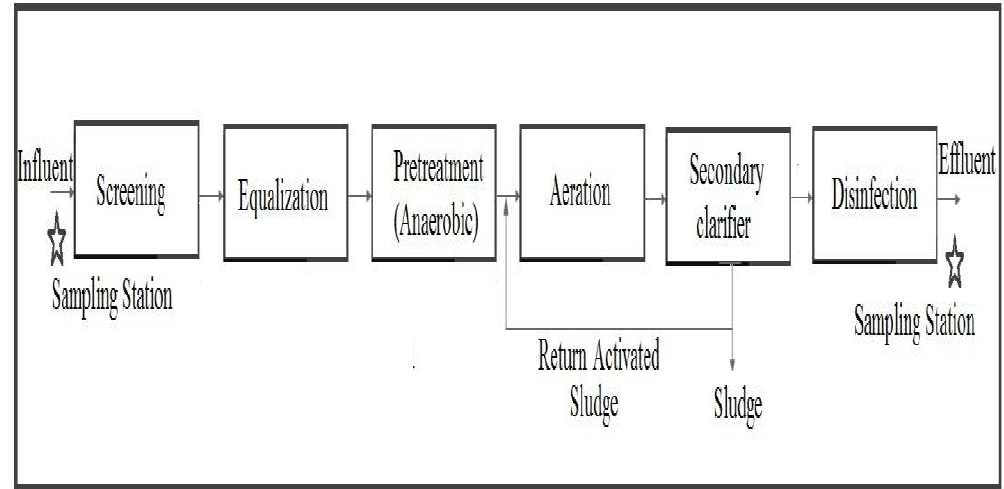
Figure 1. Flow diagram of Pelareh Dairy Industry wastewater treatment